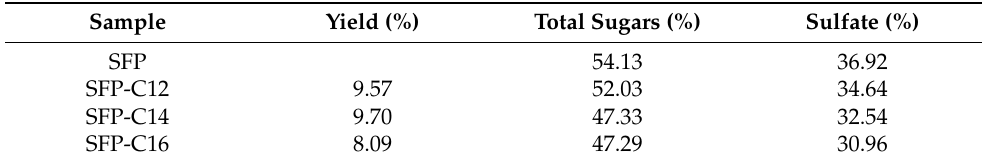
Figure 2. FT-IR spectra of SFP long-chain alkyl group derivatives.